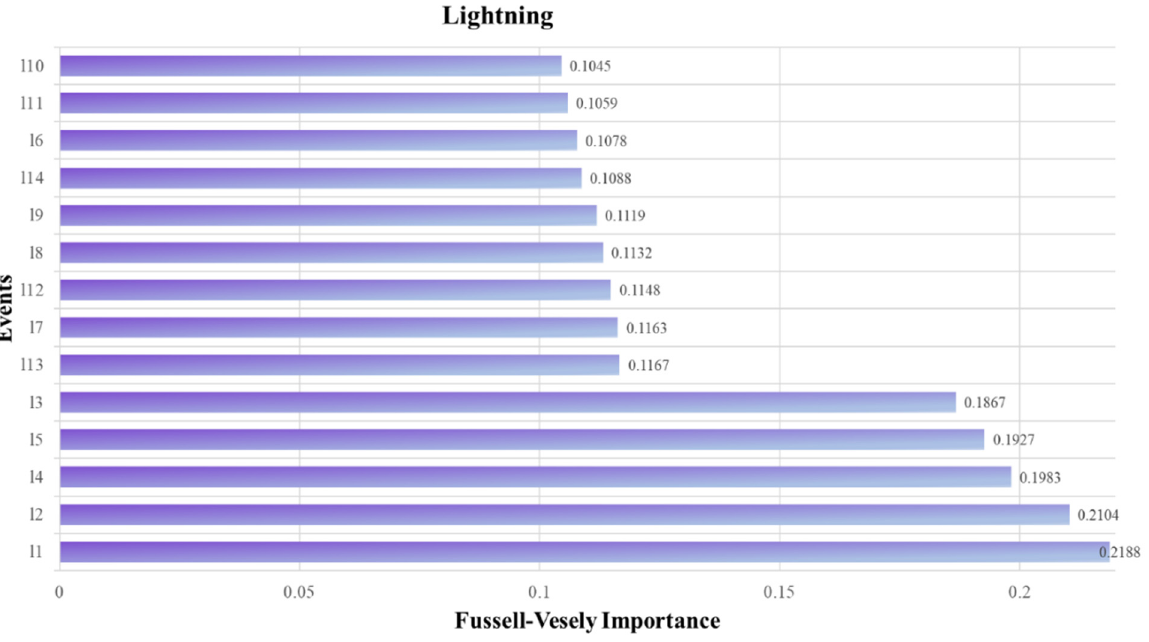
Figure 11. Fussell–Vesely Importance of each basic event of a lightning